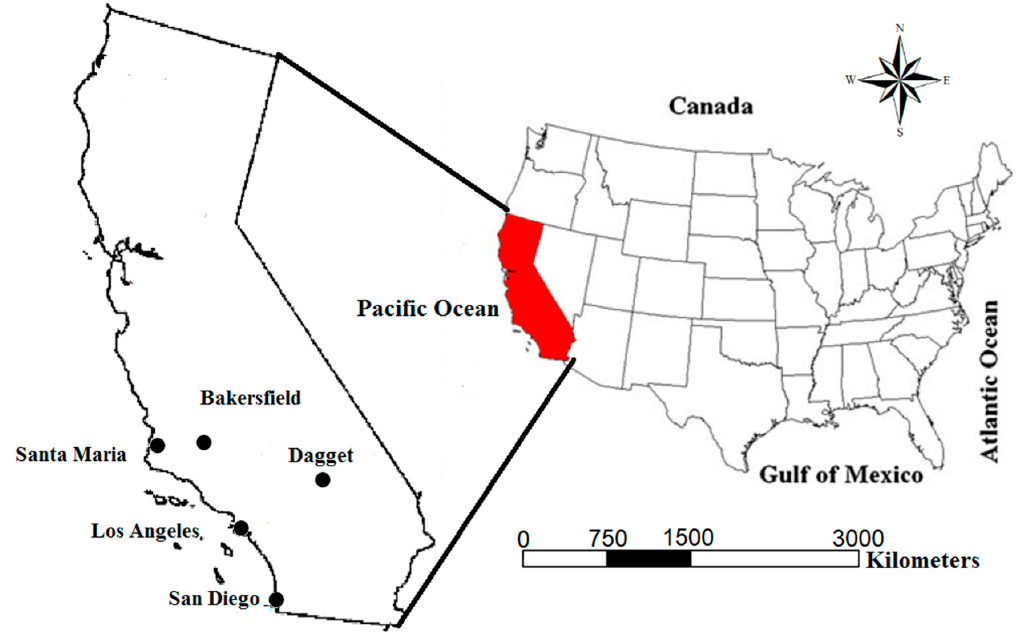
Figure 1. Map showing the locations of five meteorological stations in California, USA.